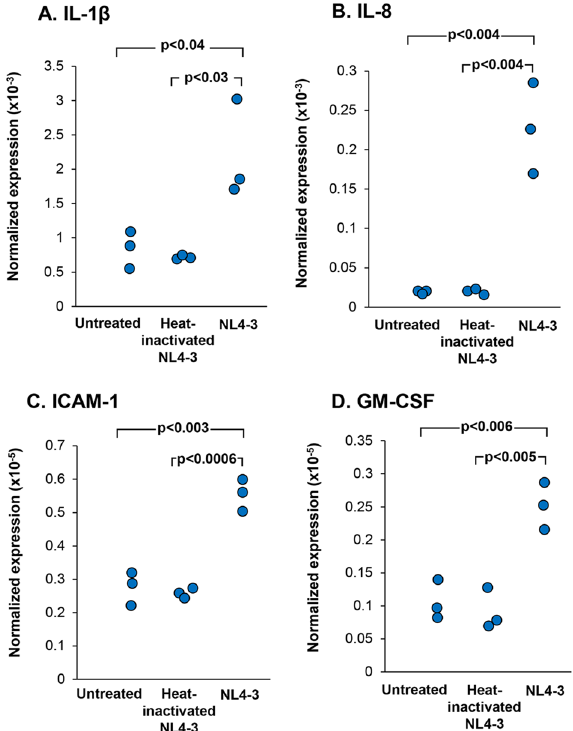
Figure 2. HIV induced cytokine gene expression by airway BC. BC were exposed to HIV or heat-inactivated HIV for 2 days. TaqMan quantitative PCR analysis was performed to assess cytokine gene expression shown in